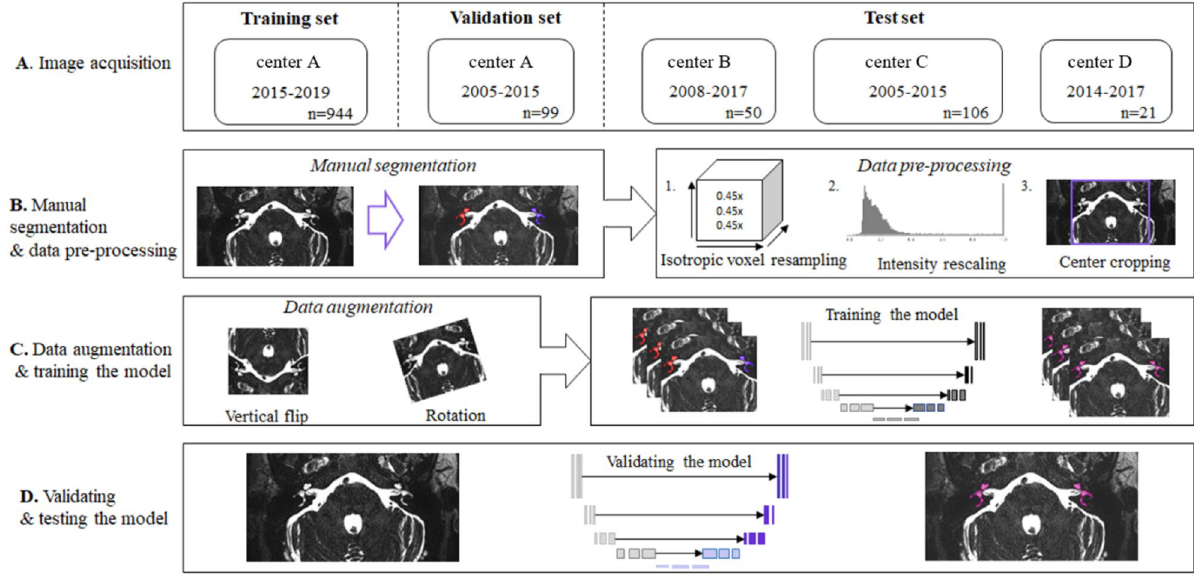
Figure 1. The workflow of autosegmentation of the inner ear in this study, graphically presented in four steps. ( A ) The image acquisition from four different centers divided into training, validation and an independent test set. ( B ) Manual segmentation of the labyrinth and pre-processing steps consisting of isotropic voxel resampling, intensity rescaling and center cropping. ( C ) Extending the data set (data augmentation) by flipping and rotating the input images and training of the model. ( D ) Validation and testing the model on an independent test cohort.